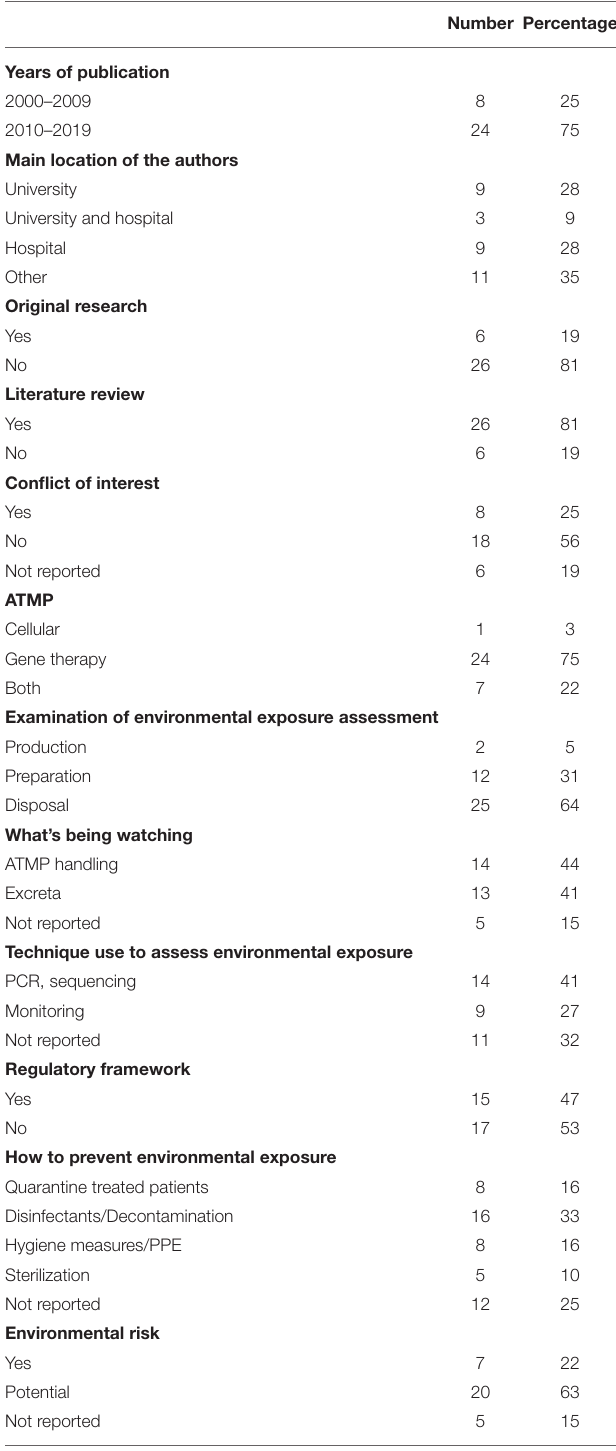
TABLE 2 | Synthesis of basic elements of 32 included